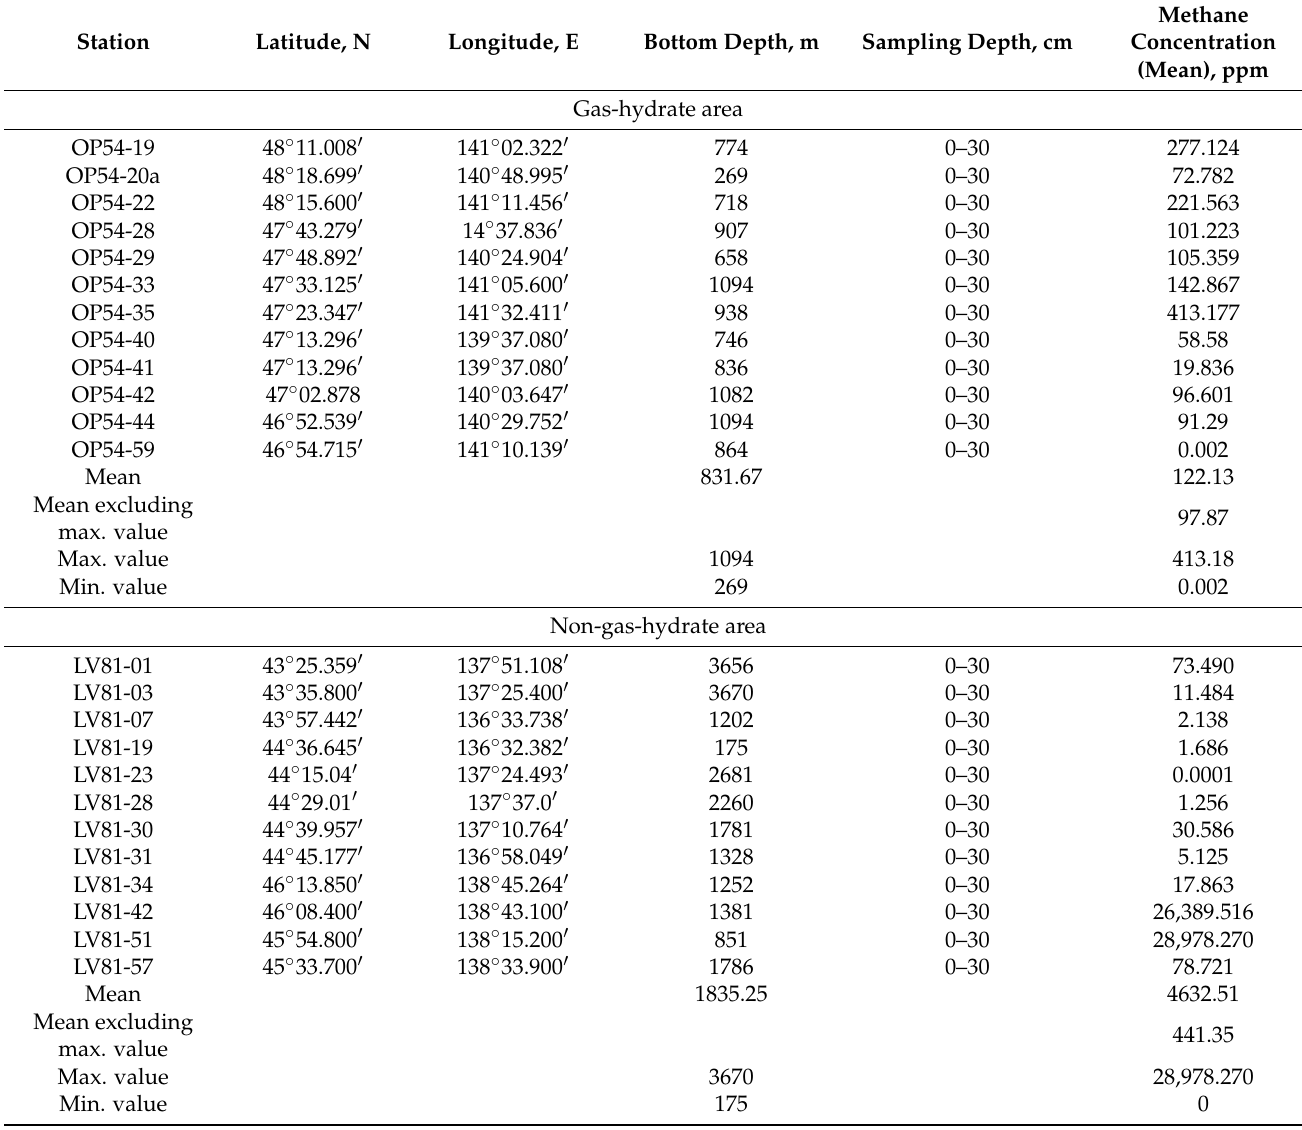
Table 1. Characteristics of the samples selected for research in the gas-hydrate and non-gas-hydrate region in the northern part of the Sea of